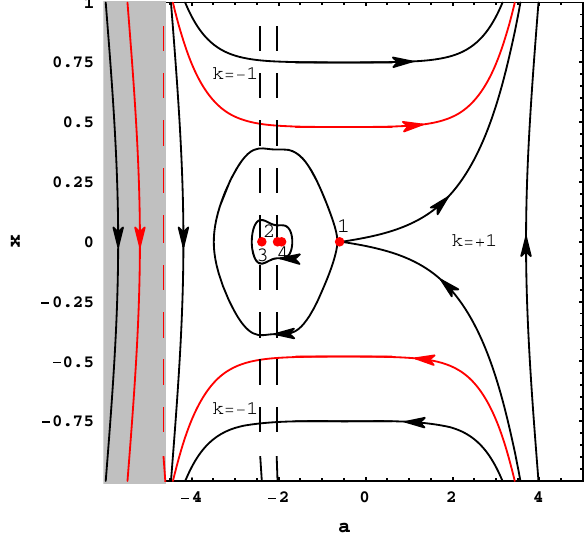
Fig. 2 The zoomed region of Fig. 1. The behavior of trajectories in Fig. 1 The phase portrait for system (15)–(16) with f ( ˆ R ) = ˆ R + (cid:3) (cid:4) (cid:3) (cid:4) the neighborhood of critical points (2), (3) and (4) which represent the s 2 Mpc 2 s 4 Mpc 4 γ ˆ R 2 + δ ˆ R 3 , where γ = 10 − 6 and δ = − 10 − 14 . static Einstein universes. Critical point (2) is of saddle type and critical km 2 km 4 Criticalpoints(1),(2),(3)and(4)representthestaticEinsteinuniverses. points (3) and (4) are of center type. The black dashed lines present the Critical points (1) and (2) are of saddle type and critical points (3) freeze singularities. The scale factor is expressed in a logarithmic scale. and (4) are of center type. The red dashed line presents the sudden The homoclinic orbits represent the bouncing models, which evolution singularity. The black dashed lines present the freeze singularities. The starts and ends at the Einstein universe (critical point 2). In the domain gray color marks the non-physical domain ( f (cid:3) ( R ) < 0). The red bounded by the homoclinic orbits the oscillating models present cases trajectories represent the path of evolution for the flat universe. These without the initial singularity trajectories separate the domain with the negative curvature ( k = − 1) from the domain with the positive curvature ( k = + 1). The scale factor